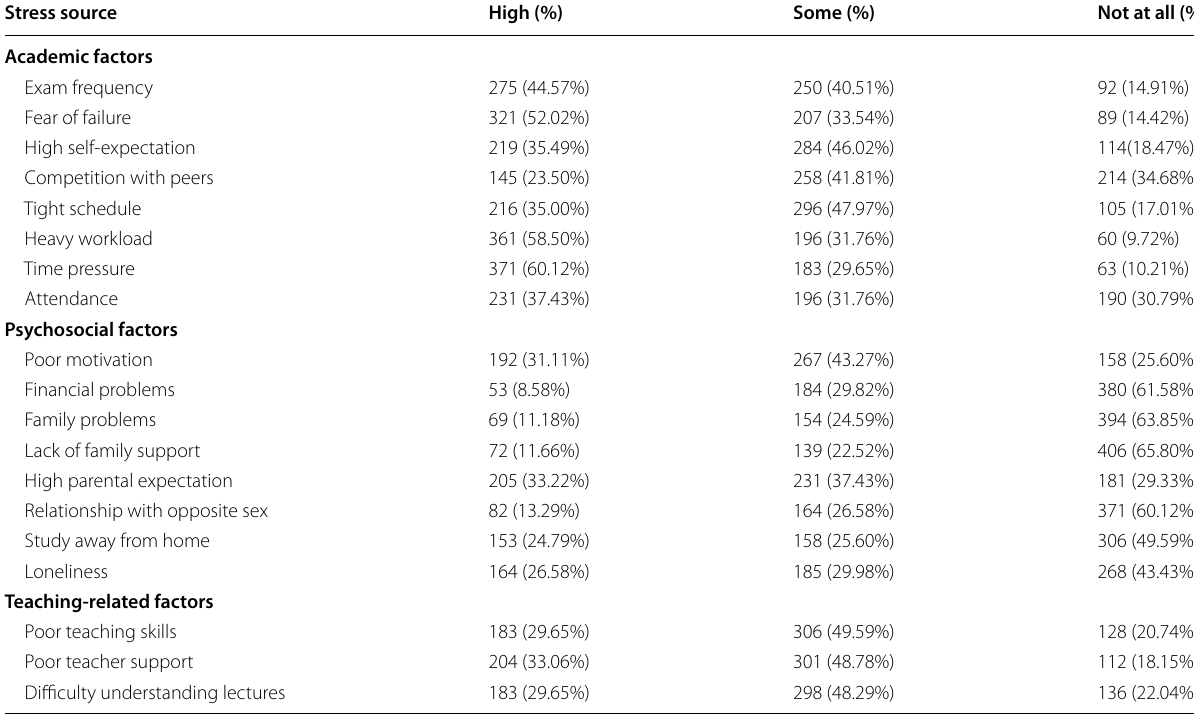
Table 2 show academic, psychosocial, and teaching-related factors have a lot, some, or no effect on medical students. Only effects of high level of stress-related symptoms were included in chronological order. For instance, factors associated with academic section that scored high were time pressure (60.3%), heavy workload (58.7%), and fear of failure 52.2%). Importantly, psychosocial and teaching-related factors were all scored less than